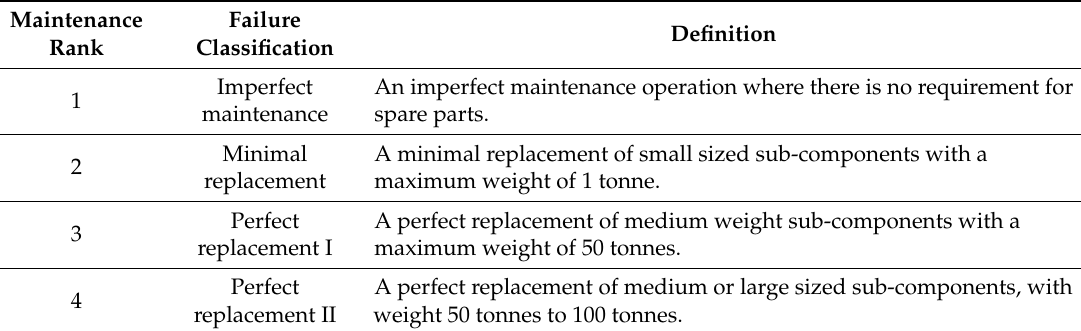
Table 1. Failure classifications for a 3 MW o ff shore wind turbine